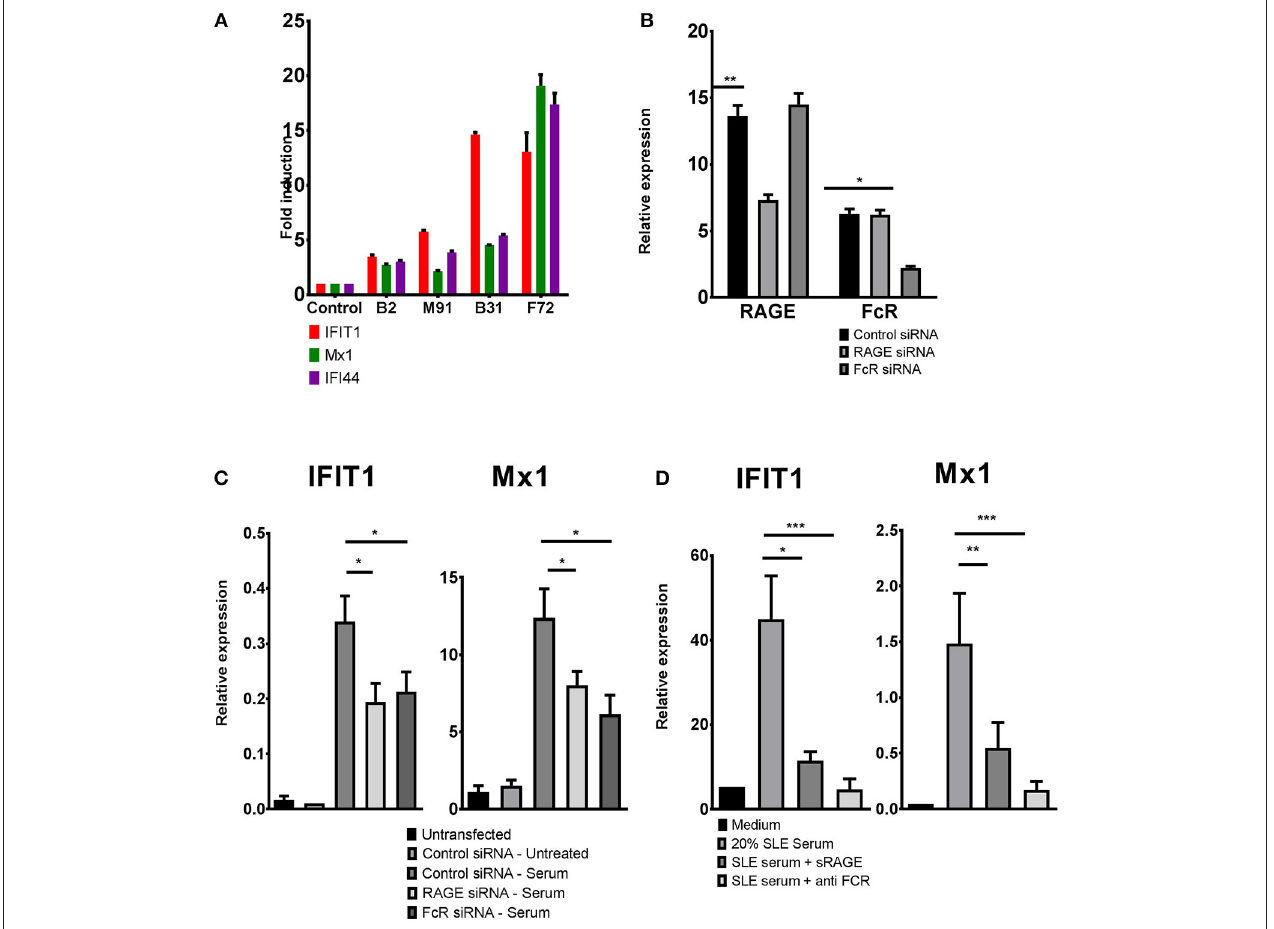
FIGURE 1 | ISG induction by SLE serum requires either RAGE or FcRlla. (A) Primary human monocytes were incubated with serum from different SLE patients, B2, M91, B31, F72, or control sera, for 4h. ISG expression was evaluated using qPCR. Data plotted represents fold induction for each gene relative to the sample incubated with control serum and is representative of 30 samples tested. (B) RAGE and FcRlla levels in monocytes treated with RAGE or FcRIIa siRNA, assessed by qPCR. (C) Monocytes were transfected with RAGE, FcRlla, or control siRNA, prior to incubation with SLE serum for 4h. For each sample (control, RAGE, or FcRlla siRNA transfected cells) fold induction of ISGs was calculated as the ratio of gene expression between treated and untreated cells. (D) Primary human monocytes were treated with SLE serum, with or without sRAGE or monoclonal anti-FcRlla antibody for 4h. ISG expression was analyzed by qPCR. Results in each case (B–D) indicate mean ± SD of three independent experiments. * p < 0.05; ** p < 0.01; *** p <